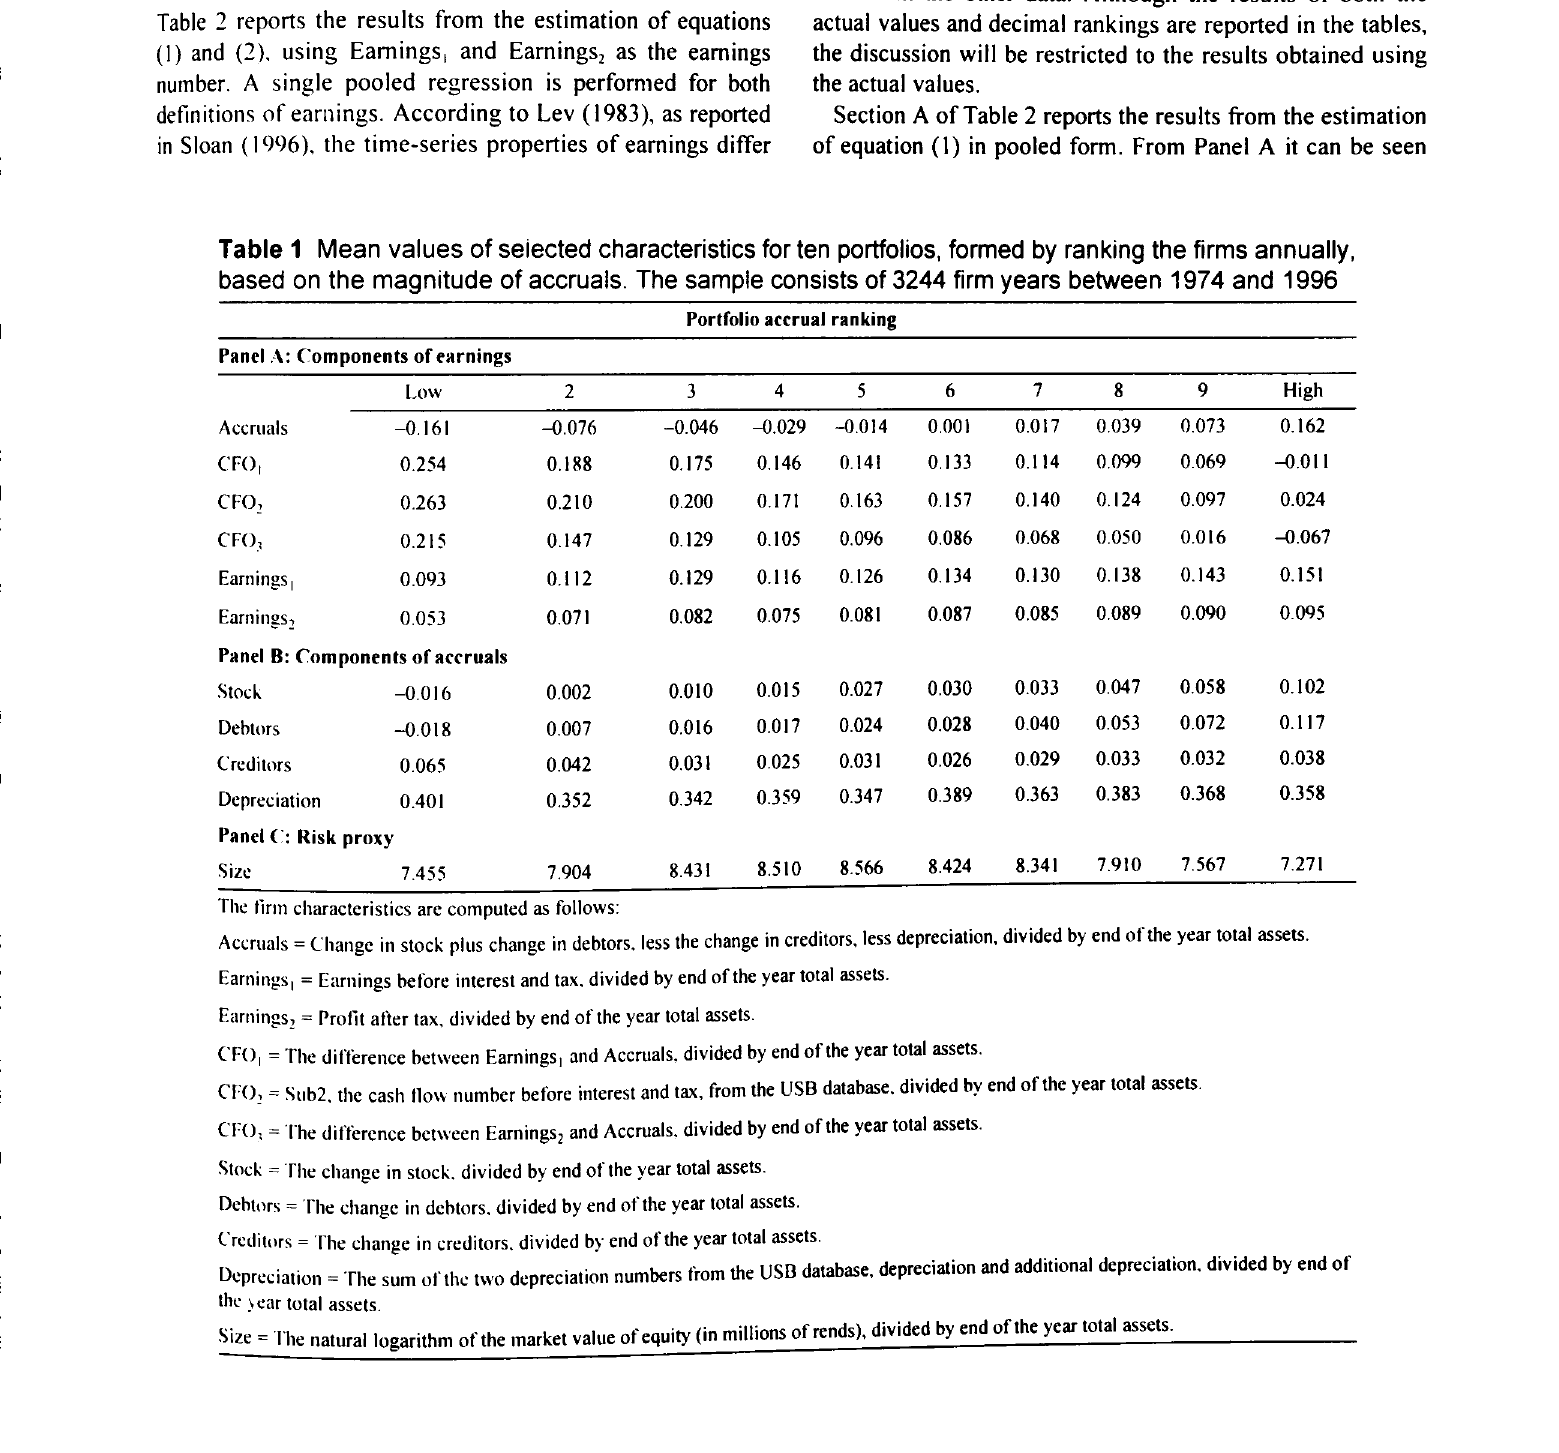
Table 1 Mean values of seiected characteristics for ten portfolios, formed by ranking the firms annually, based on the magnitude of accruals. The sample consists of 3244 firm years between 197 4 and